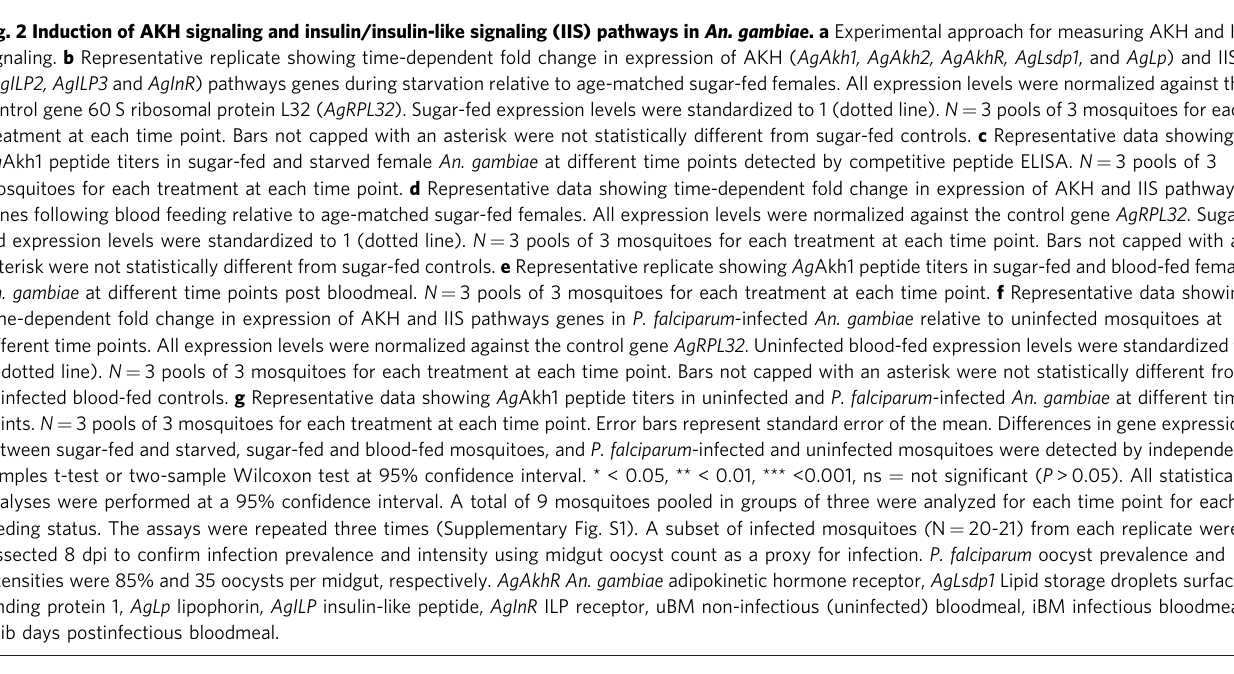
Fig. 2 Induction of AKH signaling and insulin/insulin-like signaling (IIS) pathways in An. gambiae . a Experimental approach for measuring AKH and IIS signaling. b Representative replicate showing time-dependent fold change in expression of AKH ( AgAkh1, AgAkh2, AgAkhR, AgLsdp1 , and AgLp ) and IIS ( AgILP2, AgILP3 and AgInR ) pathways genes during starvation relative to age-matched sugar-fed females. All expression levels were normalized against the control gene 60 S ribosomal protein L32 ( AgRPL32 ). Sugar-fed expression levels were standardized to 1 (dotted line). N = 3 pools of 3 mosquitoes for each treatment at each time point. Bars not capped with an asterisk were not statistically different from sugar-fed controls. c Representative data showing Ag Akh1 peptide titers in sugar-fed and starved female An. gambiae at different time points detected by competitive peptide ELISA. N = 3 pools of 3 mosquitoes for each treatment at each time point. d Representative data showing time-dependent fold change in expression of AKH and IIS pathways genes following blood feeding relative to age-matched sugar-fed females. All expression levels were normalized against the control gene AgRPL32 . Sugar- fed expression levels were standardized to 1 (dotted line). N = 3 pools of 3 mosquitoes for each treatment at each time point. Bars not capped with an asterisk were not statistically different from sugar-fed controls. e Representative replicate showing Ag Akh1 peptide titers in sugar-fed and blood-fed female An. gambiae at different time points post bloodmeal. N = 3 pools of 3 mosquitoes for each treatment at each time point. f Representative data showing time-dependent fold change in expression of AKH and IIS pathways genes in P. falciparum -infected An. gambiae relative to uninfected mosquitoes at different time points. All expression levels were normalized against the control gene AgRPL32 . Uninfected blood-fed expression levels were standardized to 1 (dotted line). N = 3 pools of 3 mosquitoes for each treatment at each time point. Bars not capped with an asterisk were not statistically different from uninfected blood-fed controls. g Representative data showing Ag Akh1 peptide titers in uninfected and P. falciparum- infected An. gambiae at different time points. N = 3 pools of 3 mosquitoes for each treatment at each time point. Error bars represent standard error of the mean. Differences in gene expression between sugar-fed and starved, sugar-fed and blood-fed mosquitoes, and P. falciparum- infected and uninfected mosquitoes were detected by independent samples t-test or two-sample Wilcoxon test at 95% con fi dence interval. * < 0.05, ** < 0.01, *** <0.001, ns = not signi fi cant ( P > 0.05). All statistical analyses were performed at a 95% con fi dence interval. A total of 9 mosquitoes pooled in groups of three were analyzed for each time point for each feeding status. The assays were repeated three times (Supplementary Fig. S1). A subset of infected mosquitoes ( N = 20-21) from each replicate were dissected 8 dpi to con fi rm infection prevalence and intensity using midgut oocyst count as a proxy for infection. P. falciparum oocyst prevalence and intensities were 85% and 35 oocysts per midgut, respectively. AgAkhR An. gambiae adipokinetic hormone receptor, AgLsdp1 Lipid storage droplets surface- binding protein 1, AgLp lipophorin, AgILP insulin-like peptide, AgInR ILP receptor, uBM non-infectious (uninfected) bloodmeal, iBM infectious bloodmeal, dpib days postinfectious